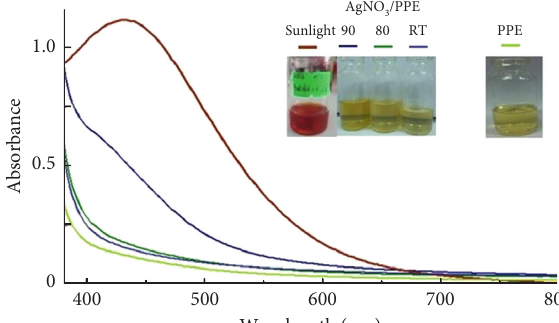
Figure 1: UV-vis spectra and appearance of PPE and AgNO (RT), 80 ° C, 90 ° C, and under sunlight.